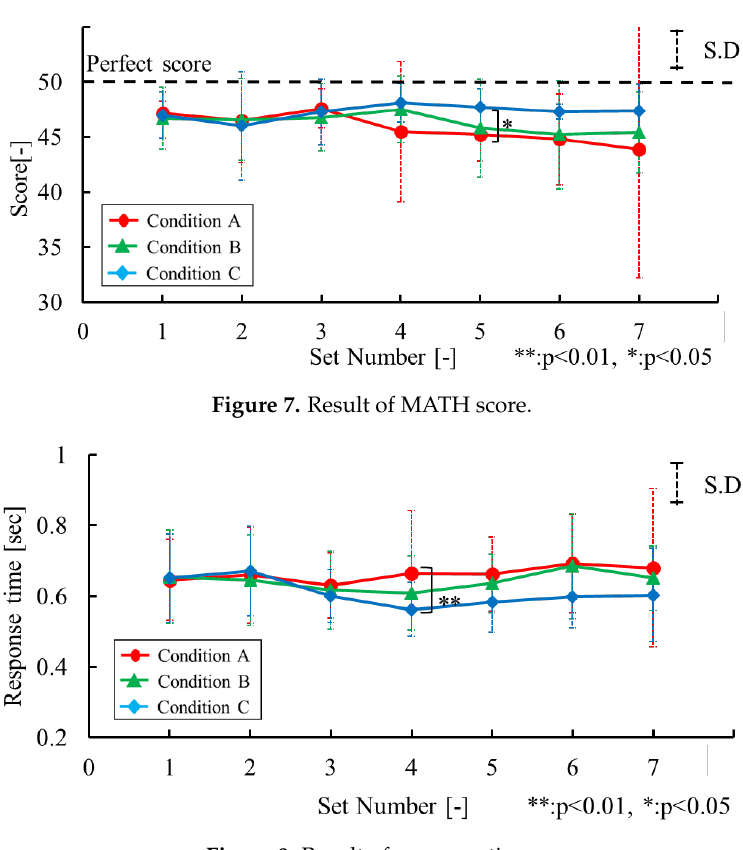
Figure 8. Result of response time.